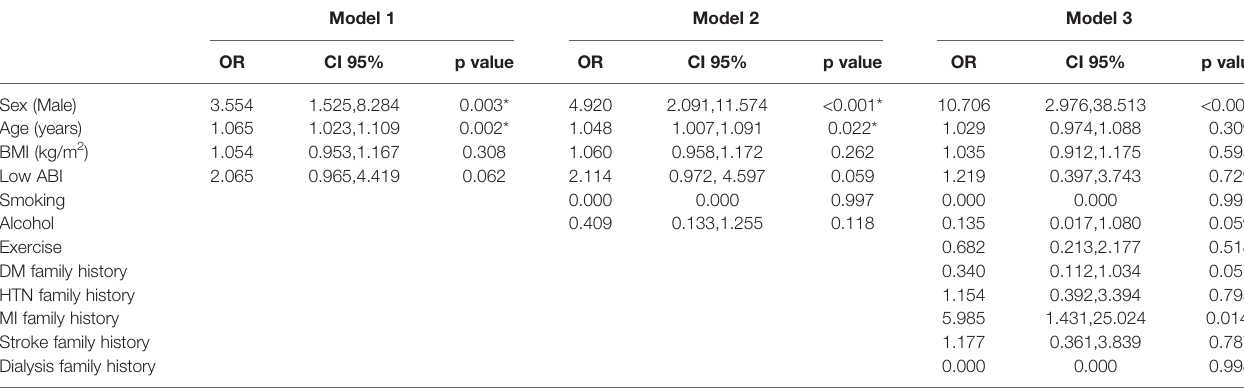
TABLE 2 | Odds ratios (OR) for myocardial infarction by logistic regression with multivariable